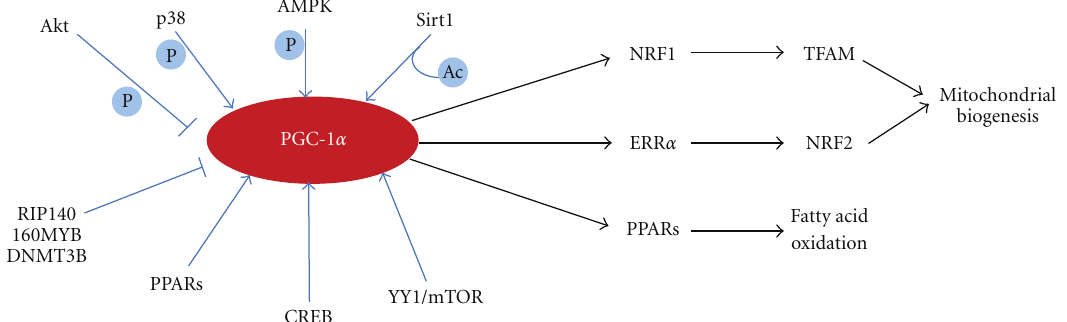
Figure 1: Modulation of PGC-1 α and its targets. Regulation of PGC-1 α activity on transcriptional and posttranscriptional levels as well as by interaction with inhibitory factors is summarized. The diagram shows the PGC-1 α targets that are involved in metabolic regulation of mitochondria. The details are discussed in the